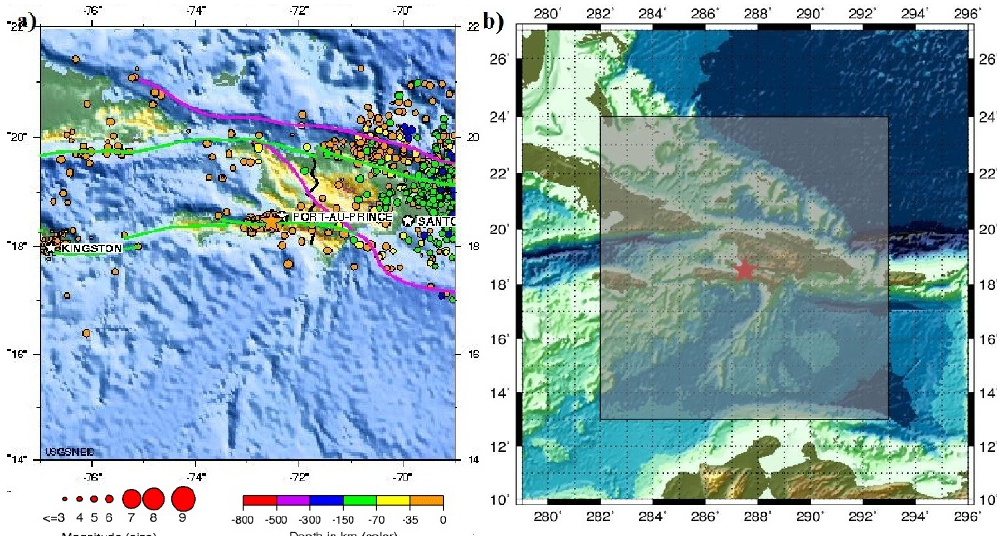
Fig. 1. (a) Historic seismicity (1990 to Present) of Haiti region. The epicenter of Haiti earthquake is marked with a star. The major tectonic boundaries (Subduction Zones – purple, Ridges – red and Transform Faults – green) are also indicated (source: USGS). (b) Map of the region of the earthquake. The epicenter is marked with a red star. The grids used in the experiment are indicated in gray. With shading interpolation function (varies the color in each line segment and face by interpolating the color map index or true color value across the line or face), each cell in matrix C (interpolated Eddy field) is colored by bilinear interpolation of the colors at its four vertices. The